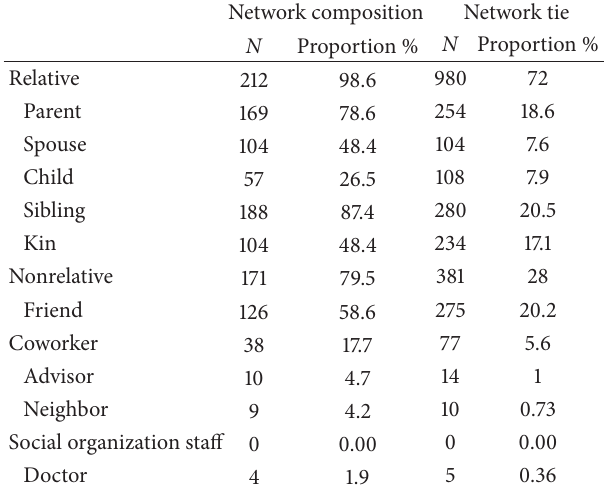
Table 3: Network composition and tie of participants in study. Network